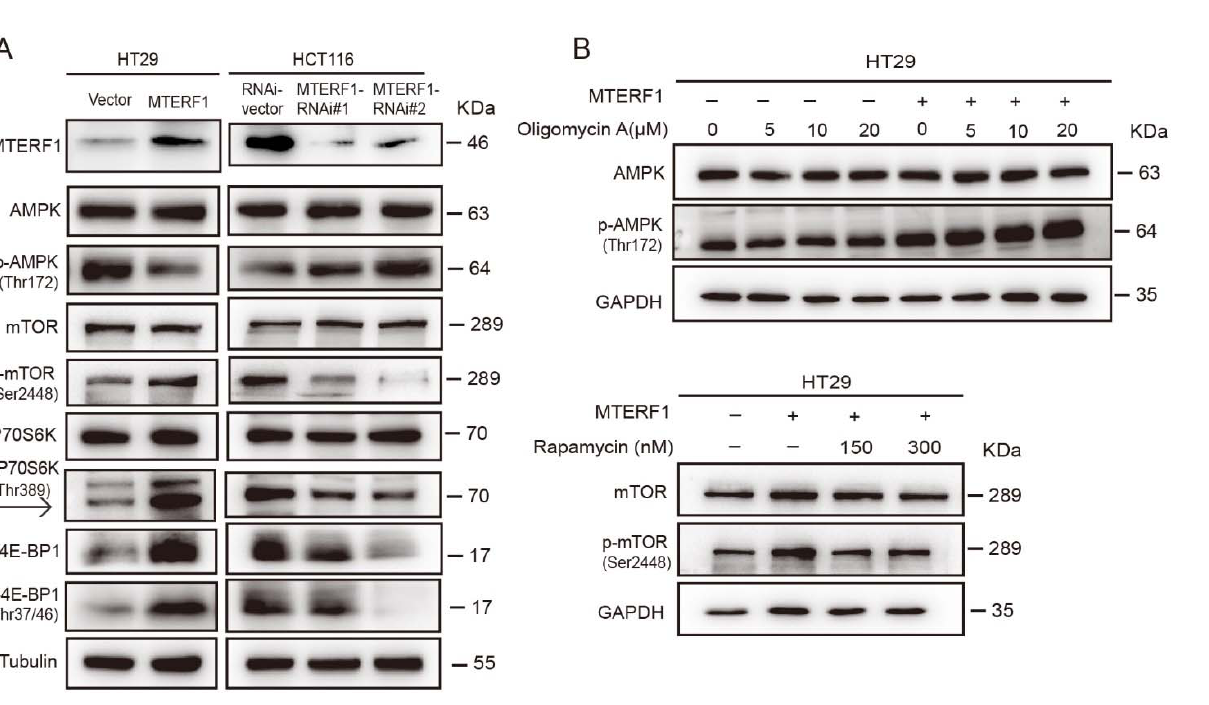
Figure 6. MTERF1 regulates the p-AMPK-mTOR signaling pathway in CRC cells. ( A ) Upregulation of MTERF1 inhibited AMPK phosphorylation and promoted mTOR phosphorylation levels, yet downregulation of MTERF1 had the opposite effect. Data represent the mean ± SD from at least three independent biological replicates. ( B ) HT29 cells overexpressing MTERF1 were treated with 0–20 μ M oligomycin A and 150–300 nM rapamycin, and the AMPK/mTOR pathway regulated by MTERF1 was blocked by oligomycin and rapamycin.